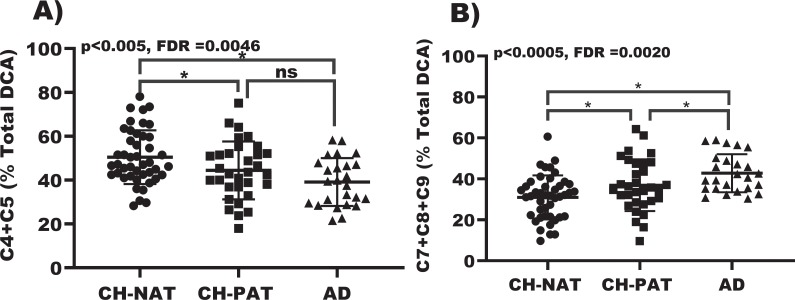
Changes in urine DCA in clinical groups.A) Violin plot and 1-way Anova with Fishers’s LSD of C4+C5 in CH-NAT, CH-PAT, and AD. B) Violin plot and 1-way Anova with Fishers’s LSD of C7+C8+C9 in CH-NAT, CH-PAT, and AD. *p < 0.05; ns not significant.